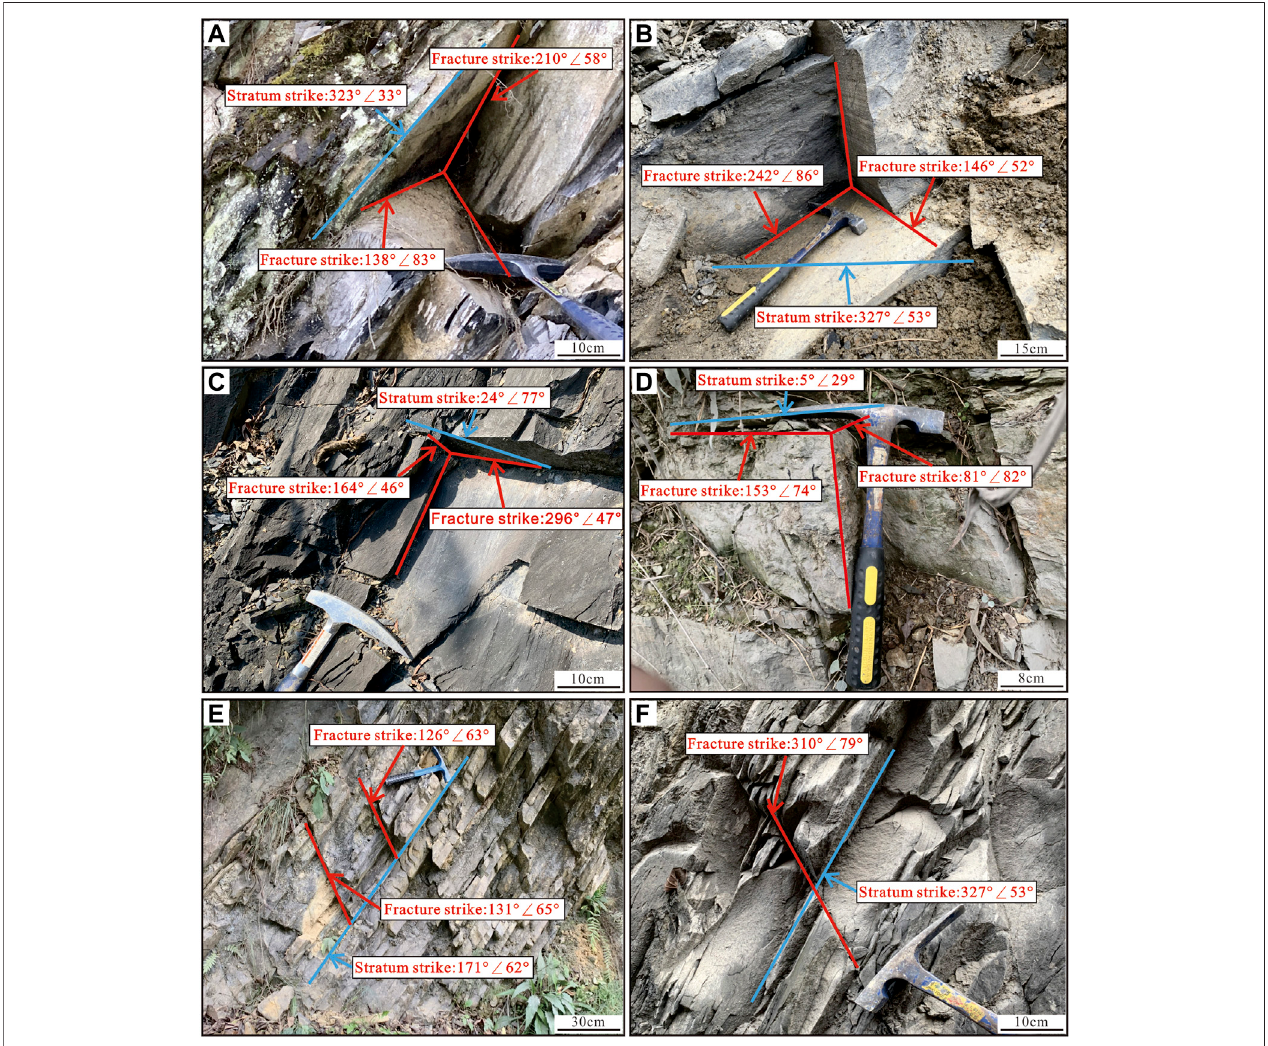
FIGURE 3 | Types and characteristics of fractures of Longmaxi Formation in outcrops. (A) . Plane shear fracture, Gaoshikan area; (B) . plane shear fracture, Banbianduarea; (C) . plane shear fracture, Huangjiaping area; (D) .plane shear fracture, Lantian area; (E) . pro fi le shear fracture, Diaolouziarea; (F) . pro fi le shear fracture, Banbiandu